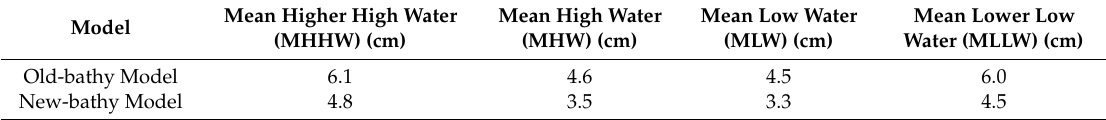
Table 2. The root mean squared errors of the modeled tidal datums relative to the observed ones. Model